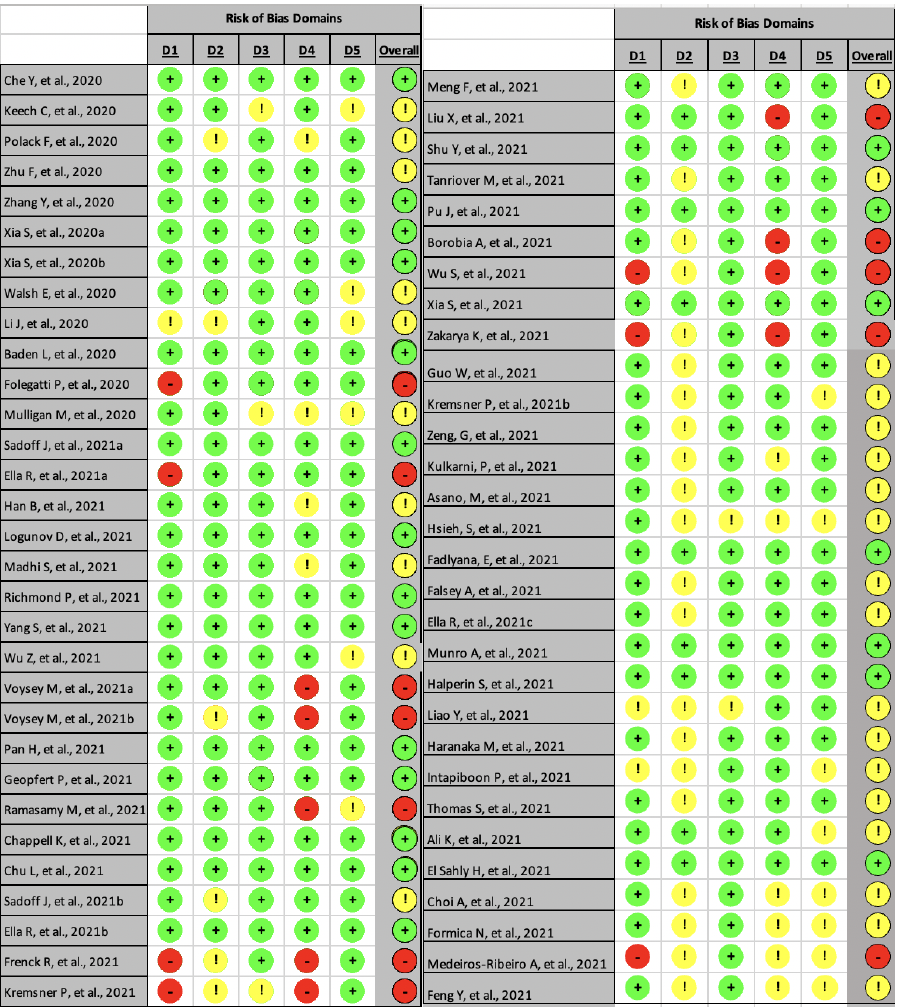
Figure 2. Summary of risk of bias analysis using ROB2 tools .